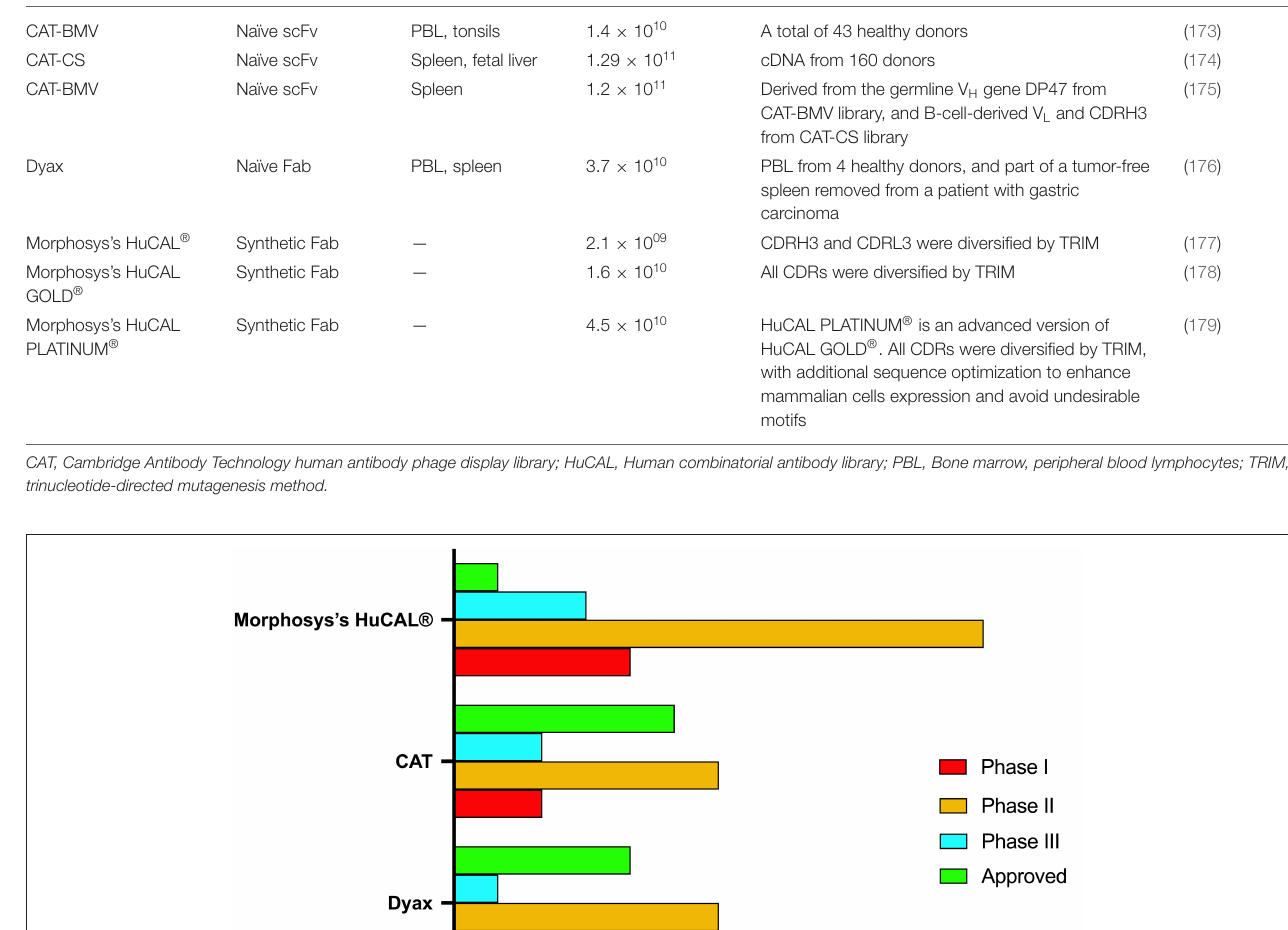
TABLE 1 | The design, construction, and features of some major company-owned antibody-phage libraries. Library